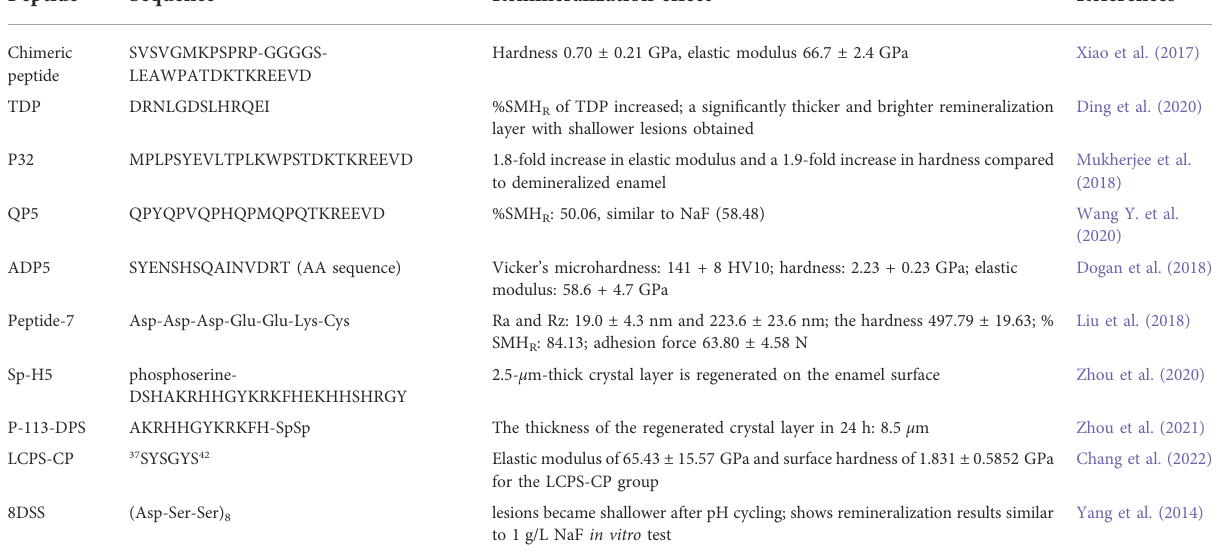
TABLE 1 Synthetic peptides for biomineralization. Peptide Sequence Remineralization effect